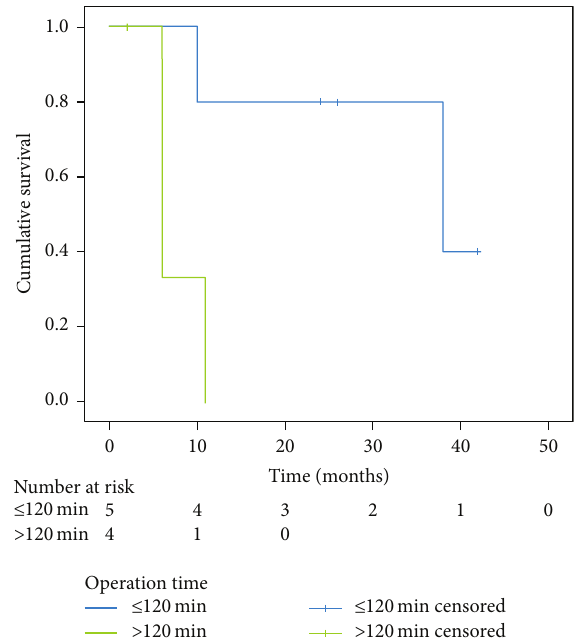
Figure 2: Kaplan-Meier survival curve of subgroups of patients with standard duration ( ≤ 120min) and long duration ( > 120min) of surgery; 𝑃 = 0, 024 .